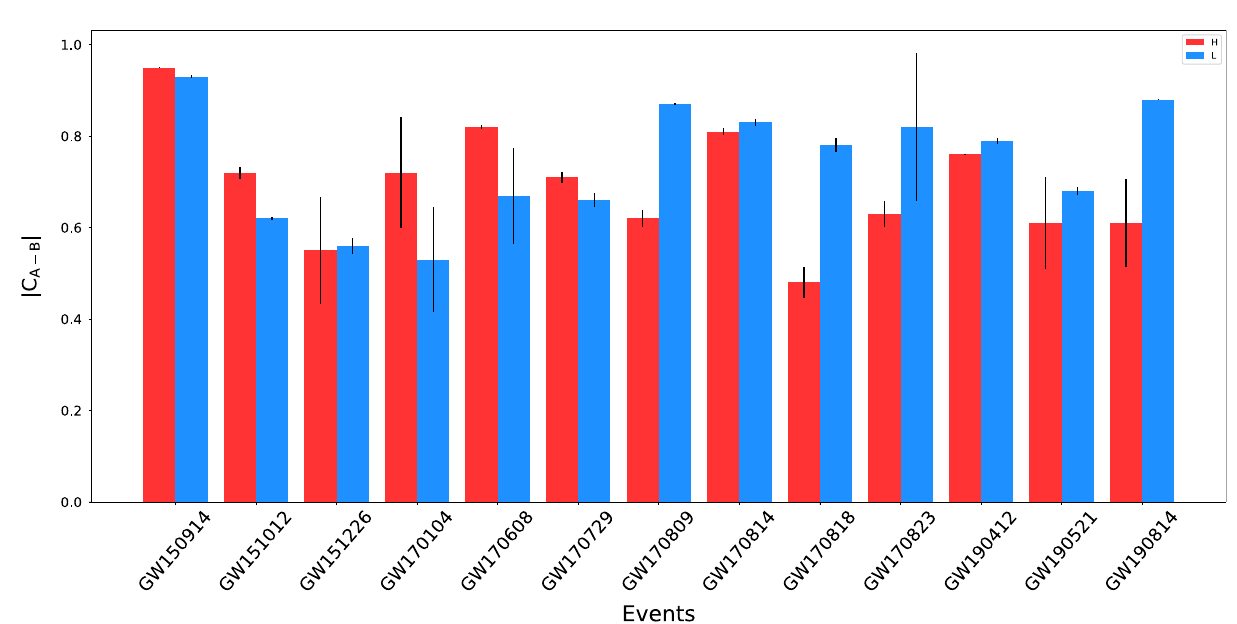
Figure 6. Cross correlation coefficients of the extracted waveforms for the events in the first, second and third observing runs O1, O2 and O3a by LIGO with waveforms generated by PyCBC library. Cross-correlation coefficients of the extracted waveforms for the event reported by LIGO with simulated waveforms generated by PyCBC library, where their waveforms are given in Fig. 4. For all events, A refers to the extracted waveform in H or L and B refers to simulated waveform for each detector 62 . Correlation coefficients between waveforms extracted from different detectors depend on two general parameters. One is the antenna pattern or the spatial angle between the detector and the GW which receives there. The other one is the SNR ratio of the recorded GW in each